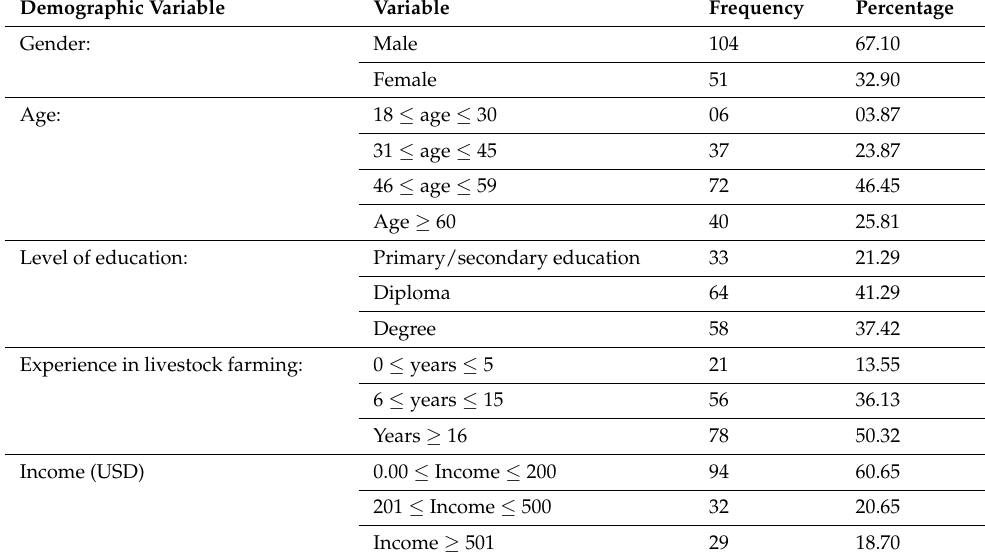
Table 1. Demographic characteristics of urban livestock